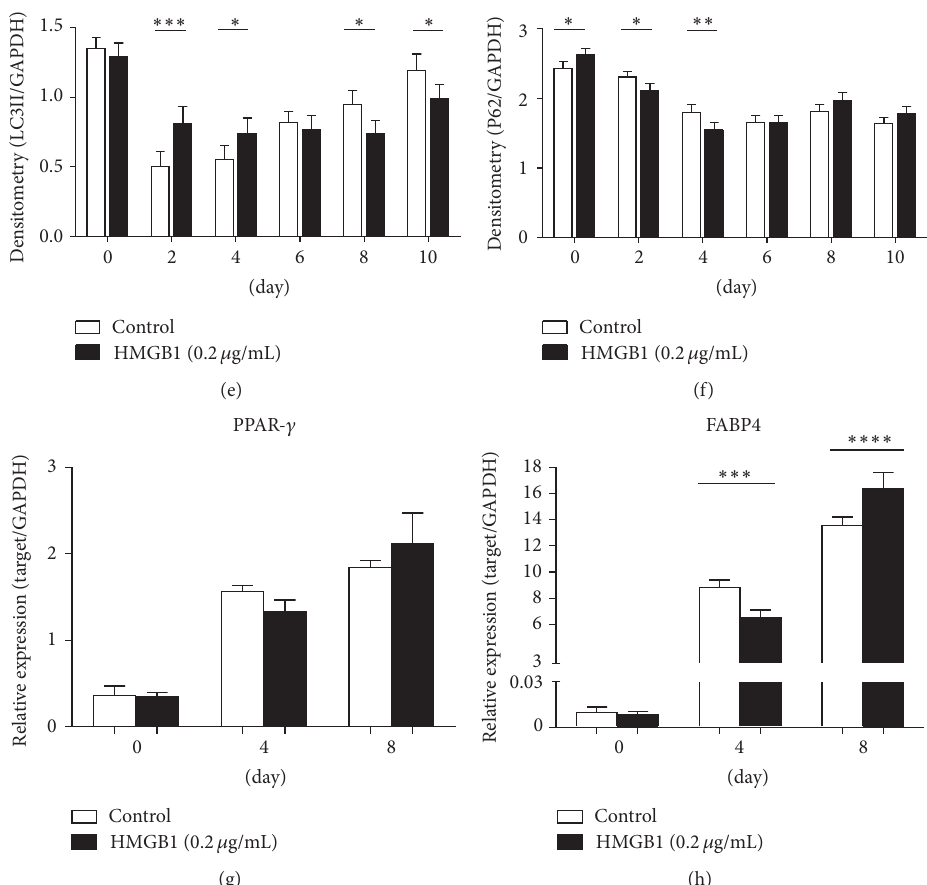
Figure 4: Effects of recombinant HMGB1 protein on autophagy in various differentiation periods of 3T3-L1 adipocytes. Differentiation of 3T3-L1 preadipocytes was induced at 0, 2, 4, 6, 8, and 10 days. The adipocytes were added with 0.2 𝜇 g/mL recombinant HMGB1 protein 24 h before differentiation. (a) Pictures were taken with a bright-field microscopic images of differentiating cells. (b) Oil-Red-O staining (200 magnification). (c) The expression of proteins HMGB1, LC3, and P62 was detected by Western blot. (d–f) HMGB1, LC3, and P62 protein were quantified and normalized to GAPDH. (g-h) Levels of PPAR- 𝛾 and FABP4 were determined by quantitative PCR in differentiation at 0, 4, and 8 days, ∗ 𝑃 < 0.05 , ∗∗ 𝑃 < 0.01 , ∗∗∗ 𝑃 < 0.001 , and ∗∗∗∗ 𝑃 < 0.0001 versus the day itself (control).